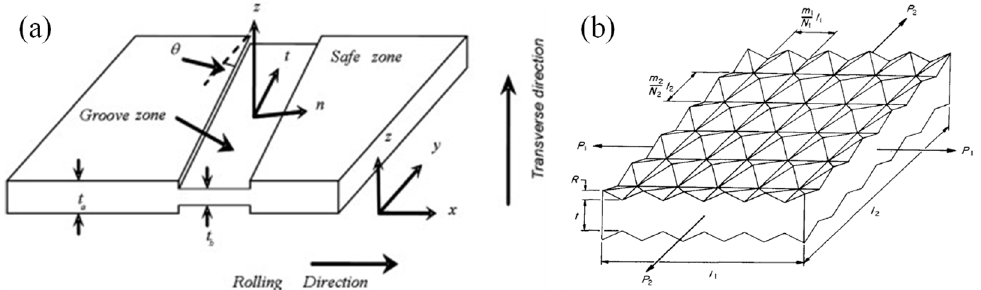
Figure 32. Schematic descriptions of the ( a ) pre-existing groove. Reprinted from Ref. [392] with permission. Copyright 2009, Elsevier; and ( b ) surface roughness considered in the modified M-K model. Reprinted from Ref. [390] with permission. Copyright 1977, Elsevier.